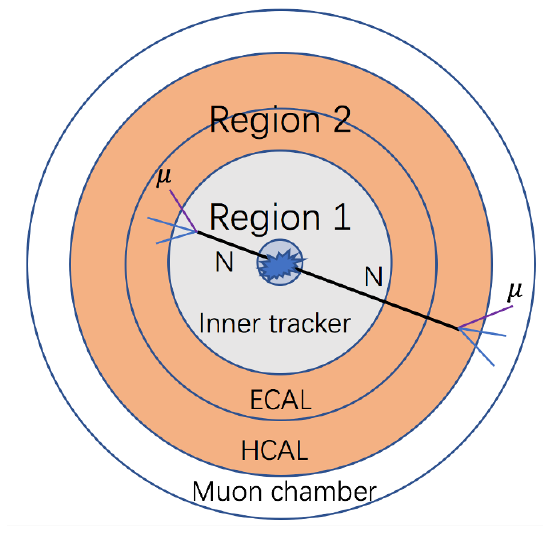
Figure 4 . Illustration of the simpli(cid:12)ed geometry of a typical detector we consider in our analysis. The innermost dark grey region is the vertex detector. The silicon tracker in light grey de(cid:12)nes Region 1. The electromagnetic calorimeter (ECAL) and hadronic calorimeter (HCAL) outside the inner tracker and inside the muon chamber de(cid:12)ne Region